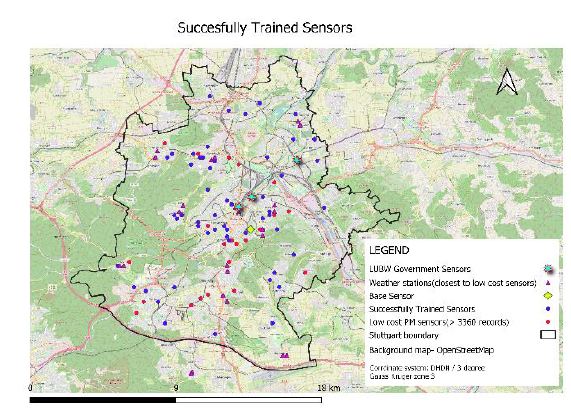
. Figure 10. Successfully trained sensors using transferred